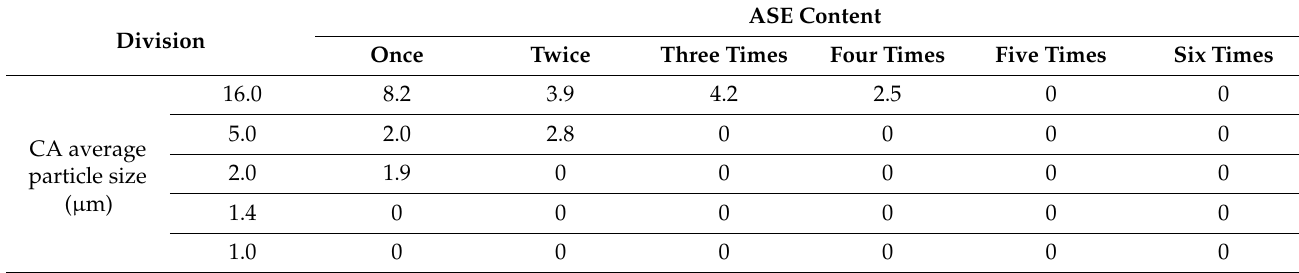
Table 7. The 20 ◦ C oil leakage stability test results (g). Table 7. The 20 °C oil leakage stability test results (g).